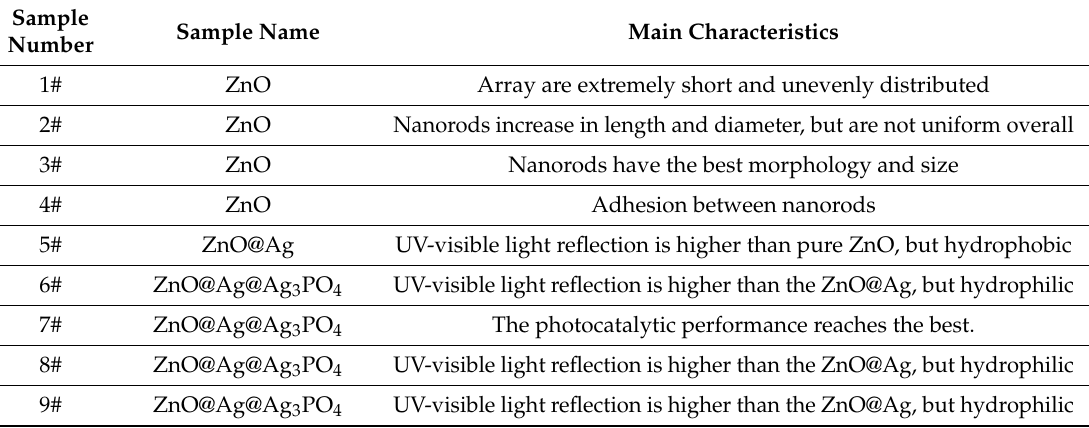
Table 1. Sample table and main features of each